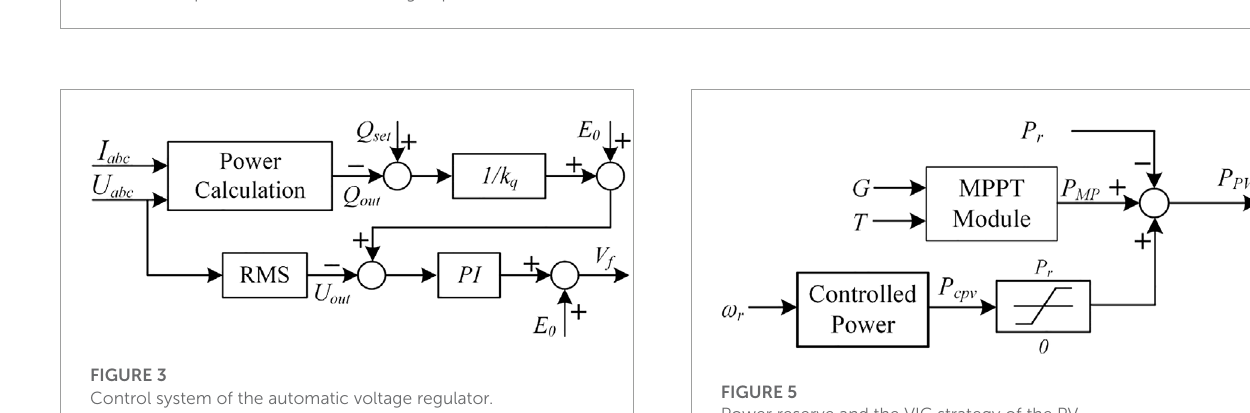
FIGURE 2 Schematic representation of the micro-grid plant model.